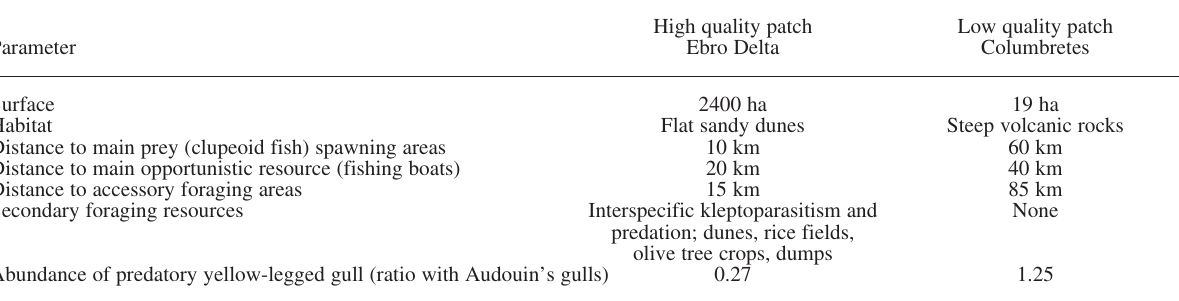
ABLE 1. – Ecological features of two neighbouring local populations of Audouin’s gull in the western Mediterranean: the Ebro Delta (high quality patch) and the Columbretes Islands (low quality patch) (see Fig. 1). Data from Oro et al. , 1996; Oro, 1998; Martínez-Abraín et al. , 2003). Distances are approximate and show an average estimate.